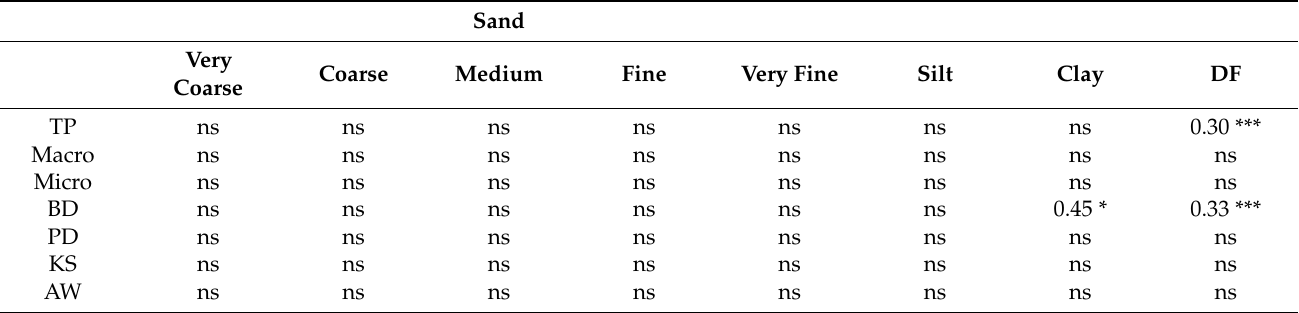
Table 8. Pearson’s correlation between the soil physical–hydric properties and the particle size and degree of flocculation of Quartzipsamments of the Southwest of Rio Grande do Sul State, southern Brazil.